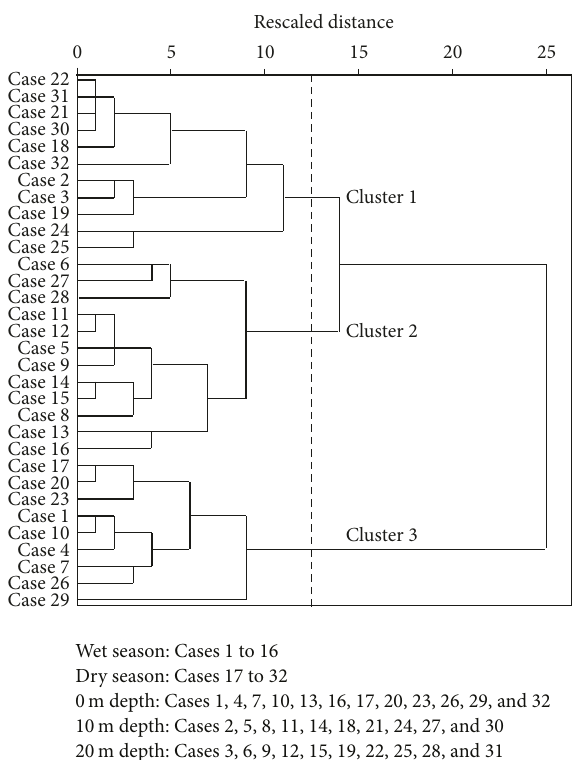
Figure 7: Clusters of the five sampling stations located in Bakun Reservoir at three different depths (0m, 10m, and 20 m) and one station located at its downstream river collected at 0m during dry and wet seasons in Sarawak,